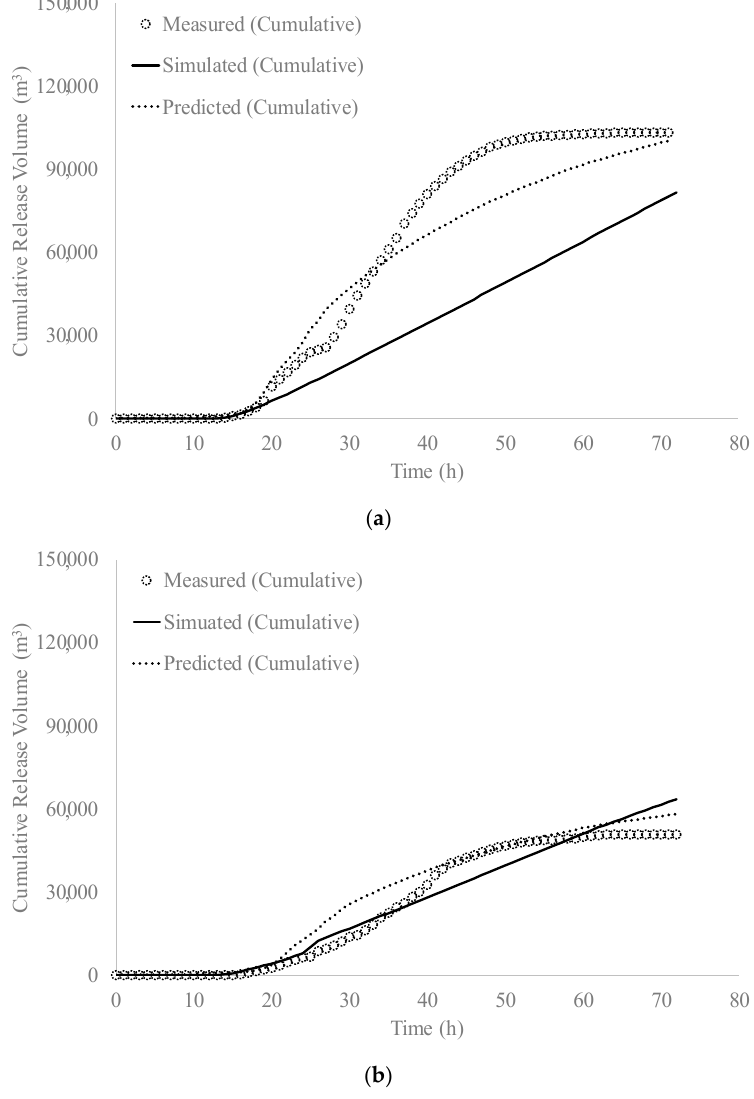
Figure 12. Released sediment through ( a ) PRO and ( b ) PPI during Typhoon Soudelor.